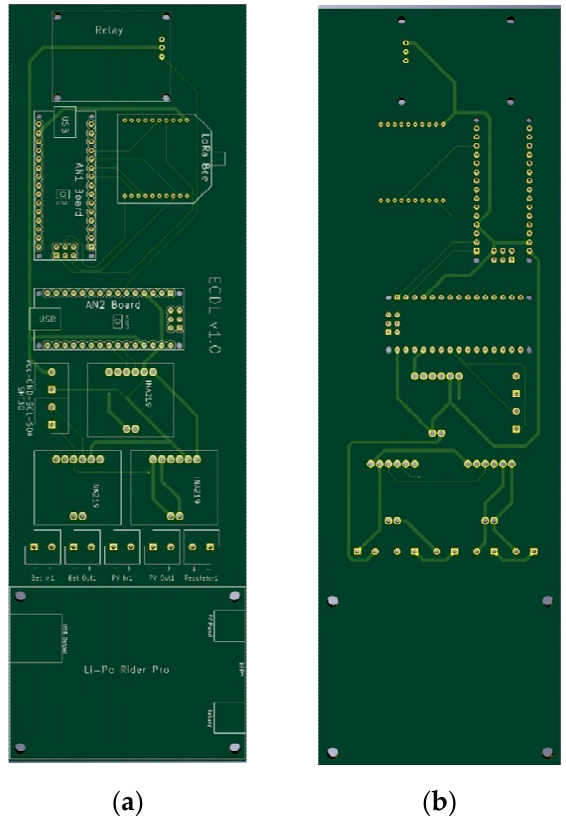
Figure 10. PCB of the ECDL with battery power supply: ( a ) front side and ( b ) back side.